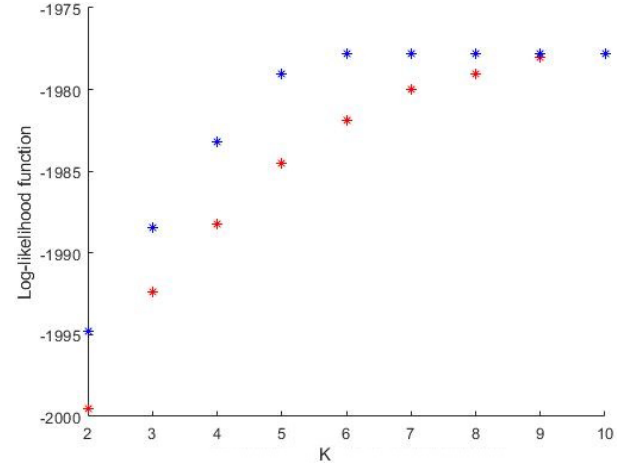
Figure 4. Exact log-likelihood value as in Eq. (5) (blue) and relaxed log-likelihood value as in Eq. (9) (red) of the reduced Bayesian model estimated by DBMR with K latent states for day for a reso- lution of 125km (64 grid boxes on a small